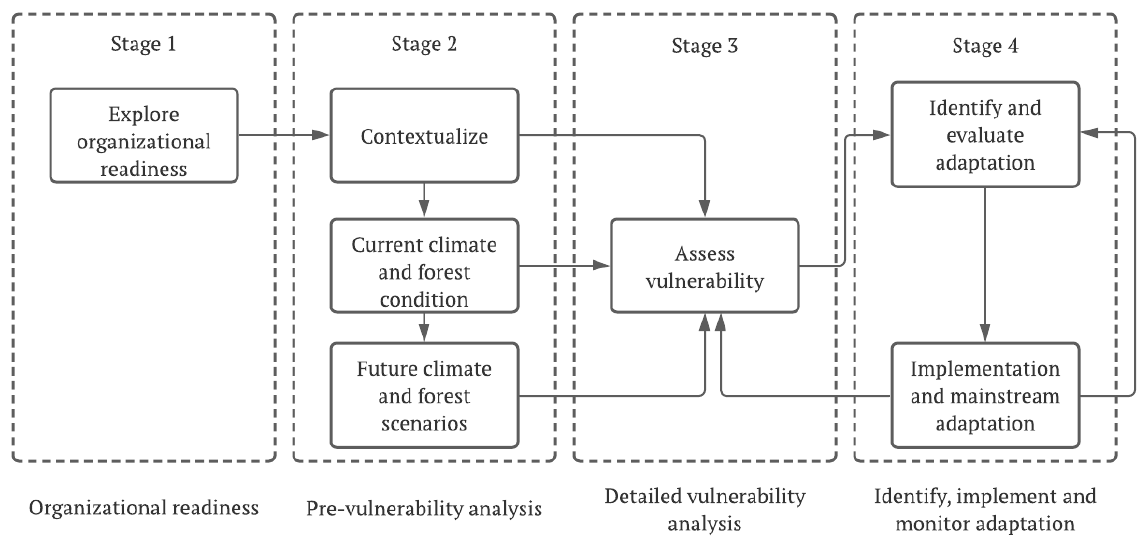
Figure 8. Four stages of adaptation to climate change in the context of sustainable forest management [66] .